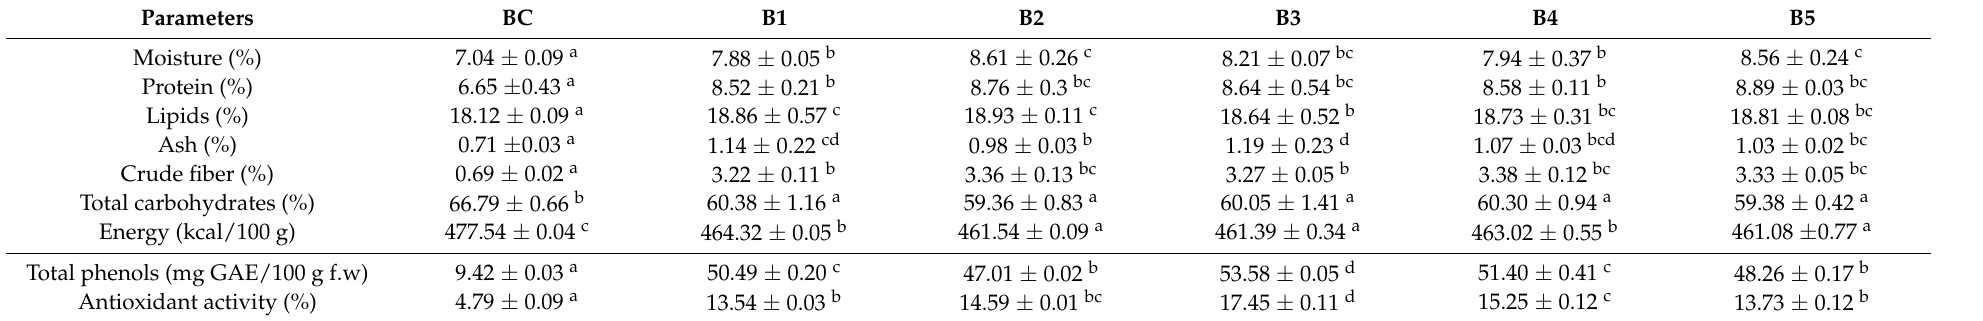
Table 5. Proximate characteristics (% f.w.) of the cookie’s